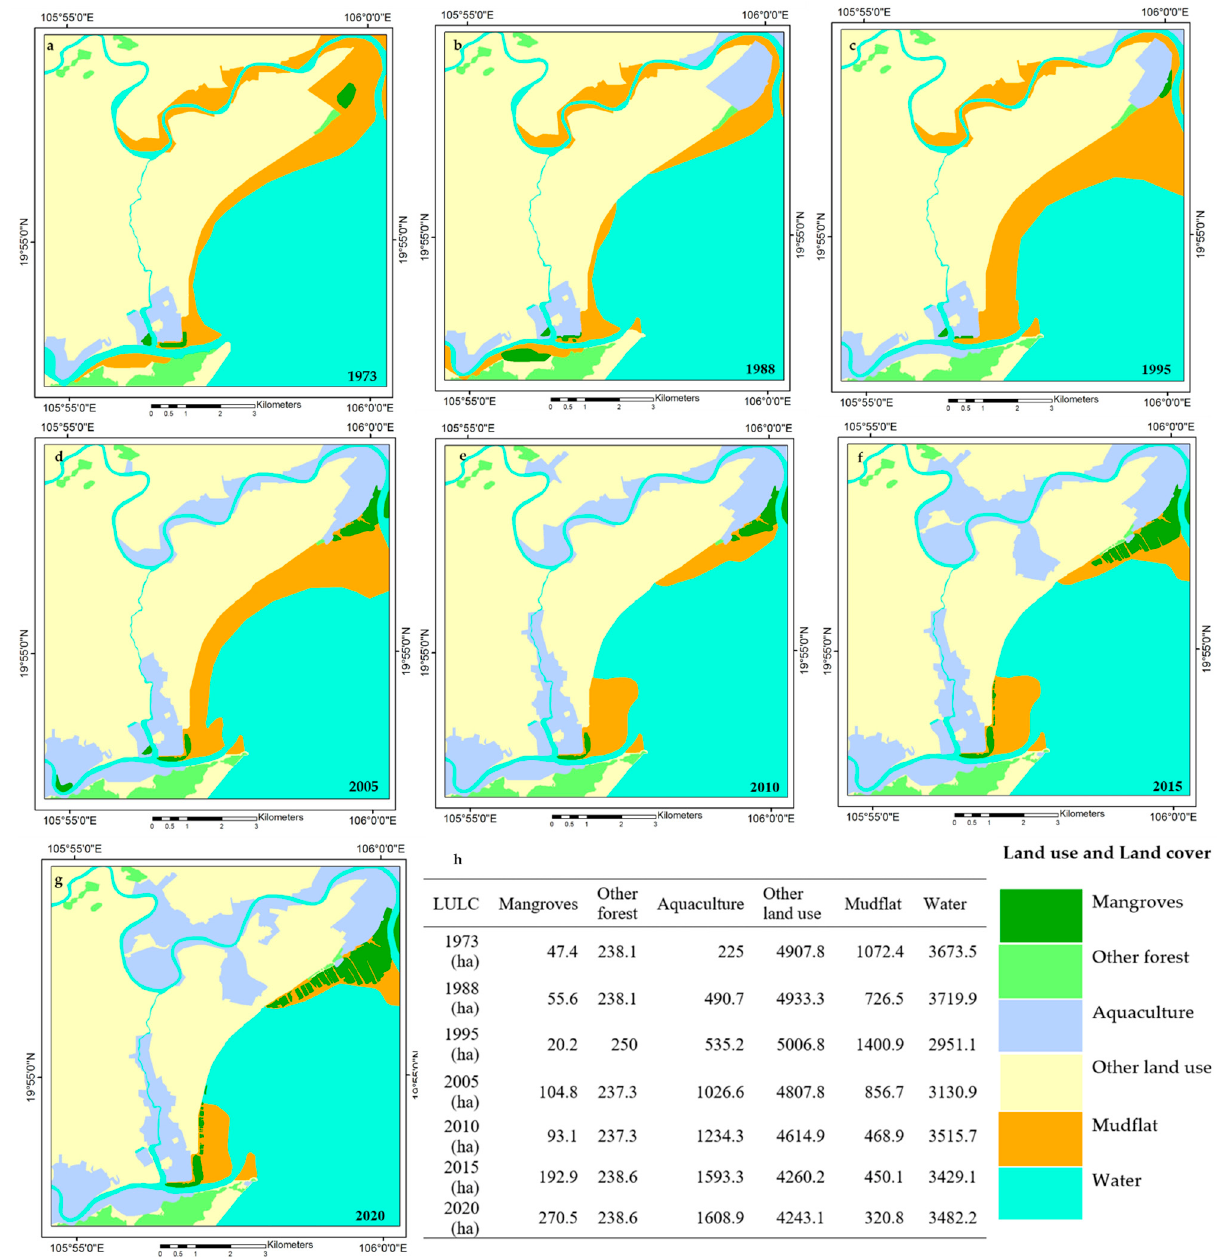
Figure 3. Land use and land cover classification map of the river mouth in Hau Loc district in Thanh Hoa province obtained from Landsat 1 for 1973 ( a ), Landsat 5 for 1988 ( b ), 1995 ( c ), 2005 ( d ), 2010 ( e ), and Landsat 8 for 2015 ( f ) and 2020 ( g ). Panel ( h ) provides the LULC (ha) for panels ( a ) to ( g ).